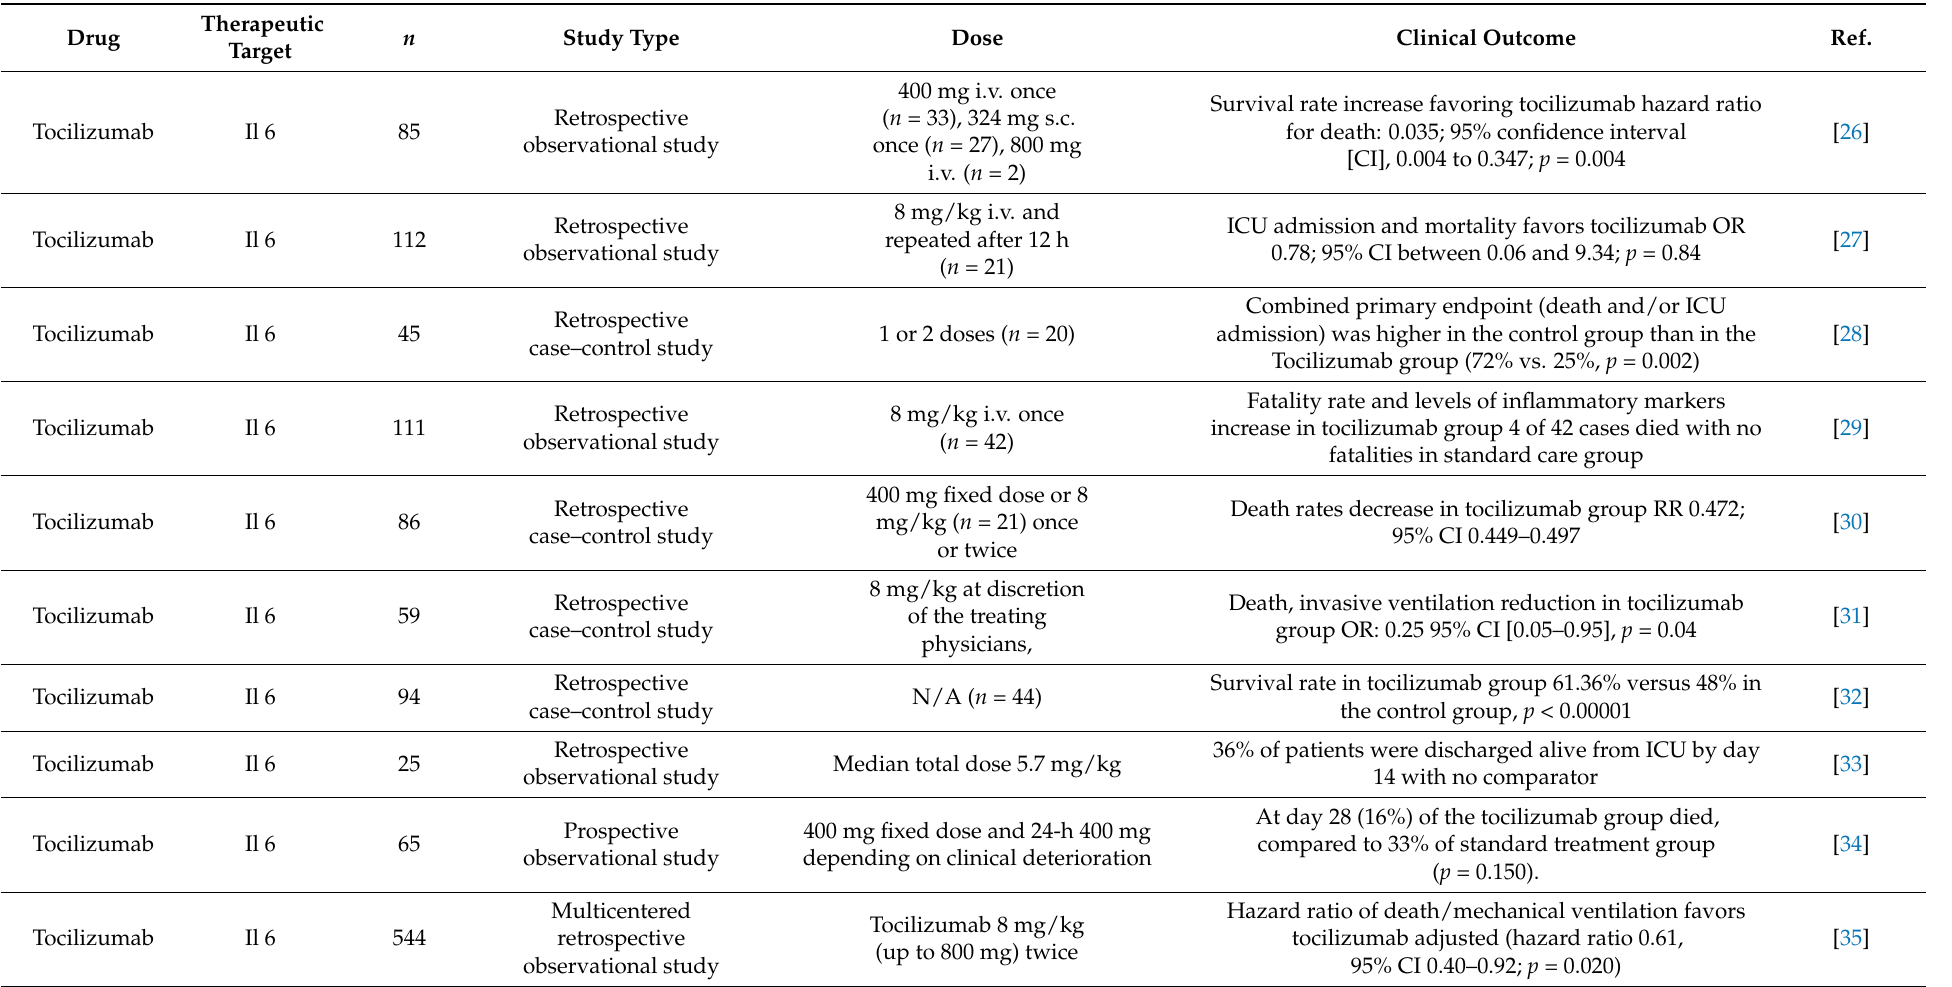
Table 1. Biotherapeutics in COVID-19